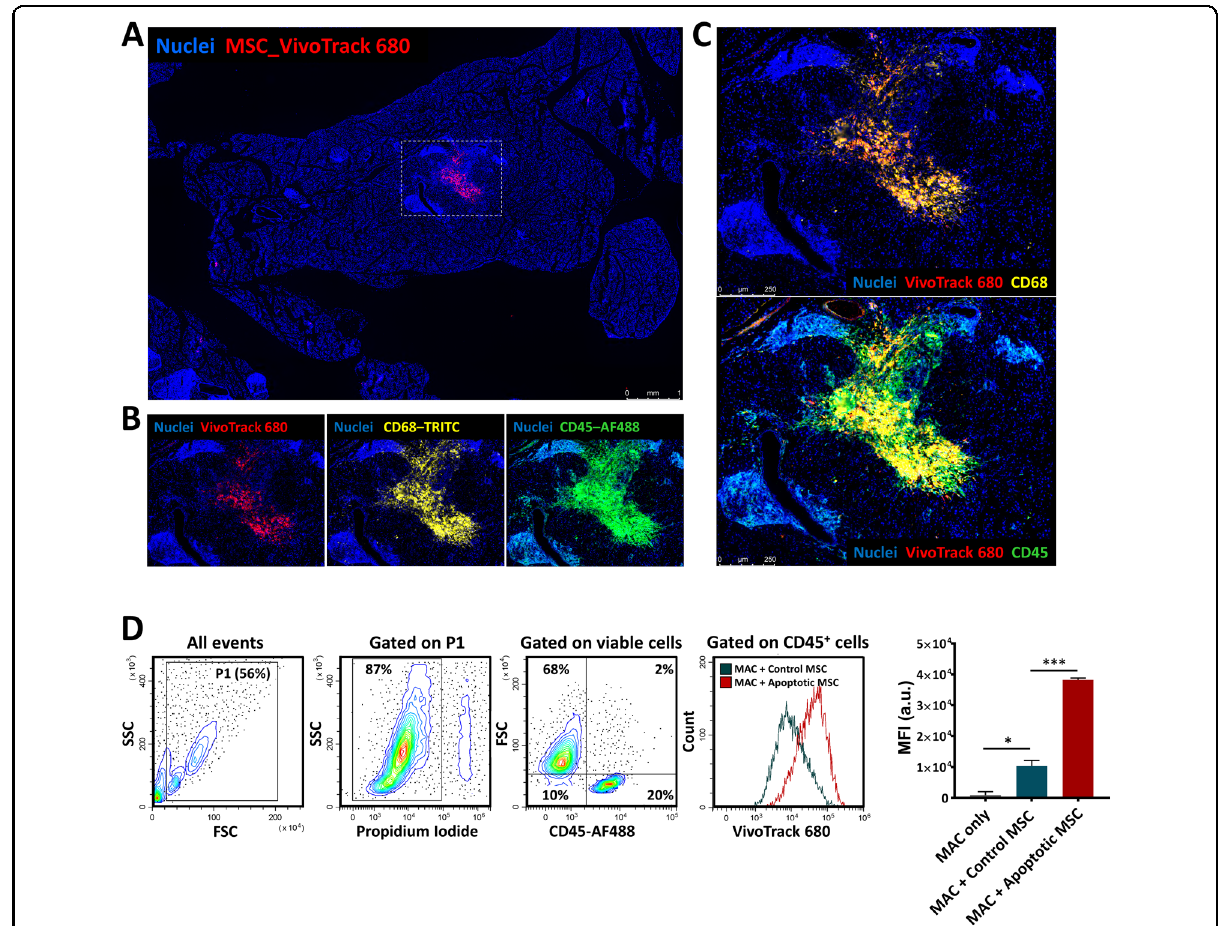
Fig. 5 In fi ltration of in fl ammatory cells after intrapancreatic transplantation of MSC. A Low-magni fi cation scan of the pancreas at 7 days after transplantation of Luc + VT680 + MSC; box indicates the area with a high VT680 signal; B Immuno fl uorescence images of the region indicated in ( A ). CD68 immunostaining denotes macrophages in fi ltrated at the transplantation site; CD45 immunostaining demarcates hematopoietic cells; C High- resolution microscopy of the region indicated in ( A ) showing the presence of cells with co-localized signal of VT680 and CD68 molecule (upper image) and co-localized signal of VT680 and CD45 molecule (lower image), thus suggesting the presence of macrophages that engulfed VT680 + MSC or VT680 + MSC-derived apoptotic bodies. D Flow cytometry analysis of peritoneal macrophages isolated from syngeneic mice co-cultured with healthy (control) or apoptotic MSC. Apoptotic MSC were obtained after 48-h culture with pro-in fl ammatory cytokines. Note the increased phagocytic activity of macrophages when in presence of apoptotic cells as compared to healthy